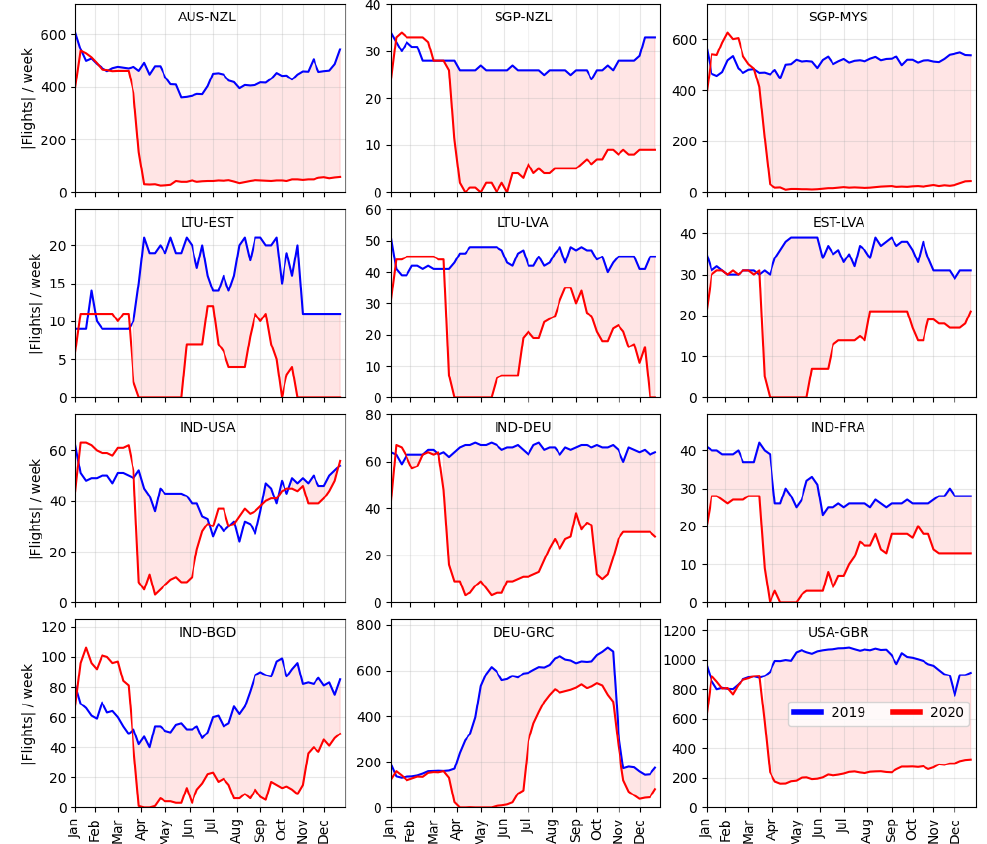
Figure 1. The number of flights per week between selected countries pairs, comparing data for 2019 (blue) and 2020